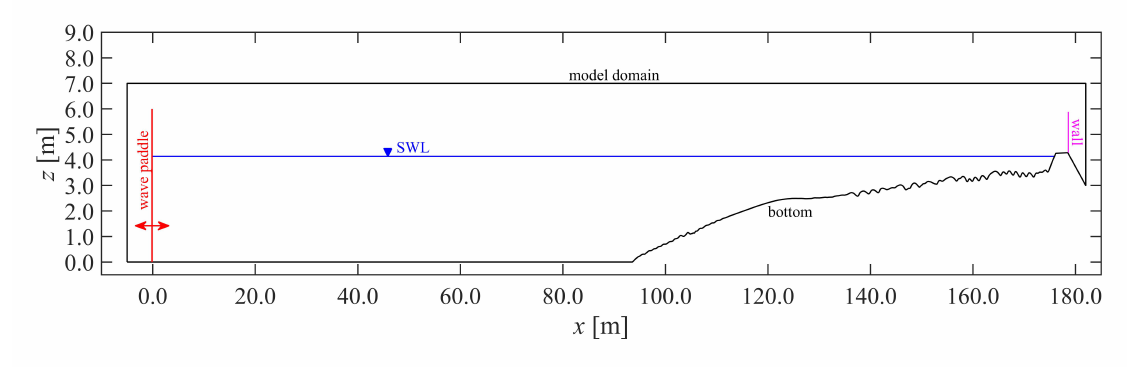
Figure 2. Definition of the DSPH 2DV computational domain, with coloured indication of the model fixed and movable boundaries. The still water level (SWL) is indicated in blue (z = 4.14 m). Note: The axes are in a distorted